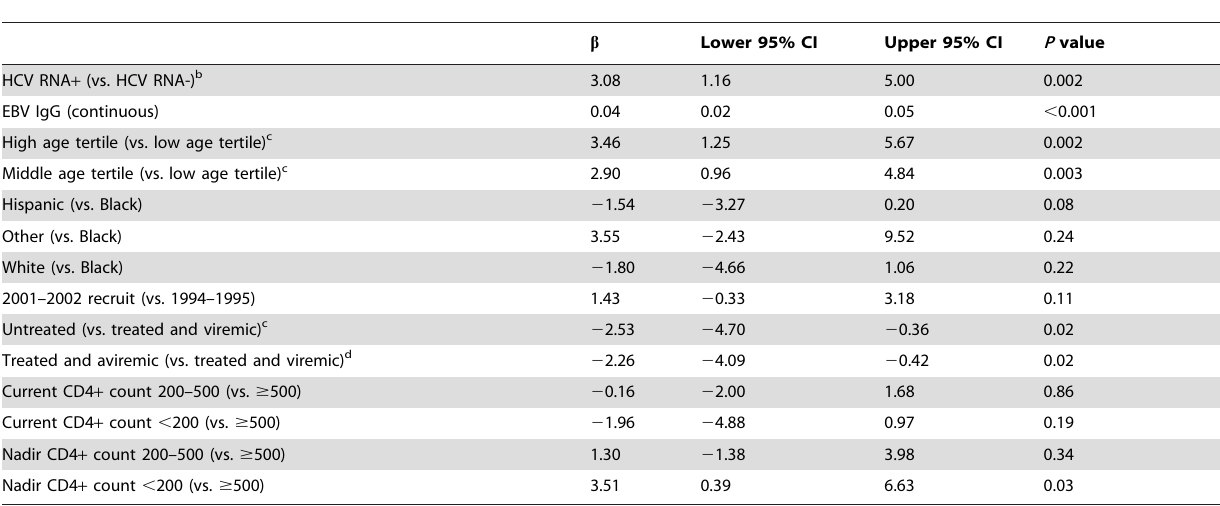
Table 3. Independent associations of HCV RNA status and covariates with CMV IgG (IU/mL) a